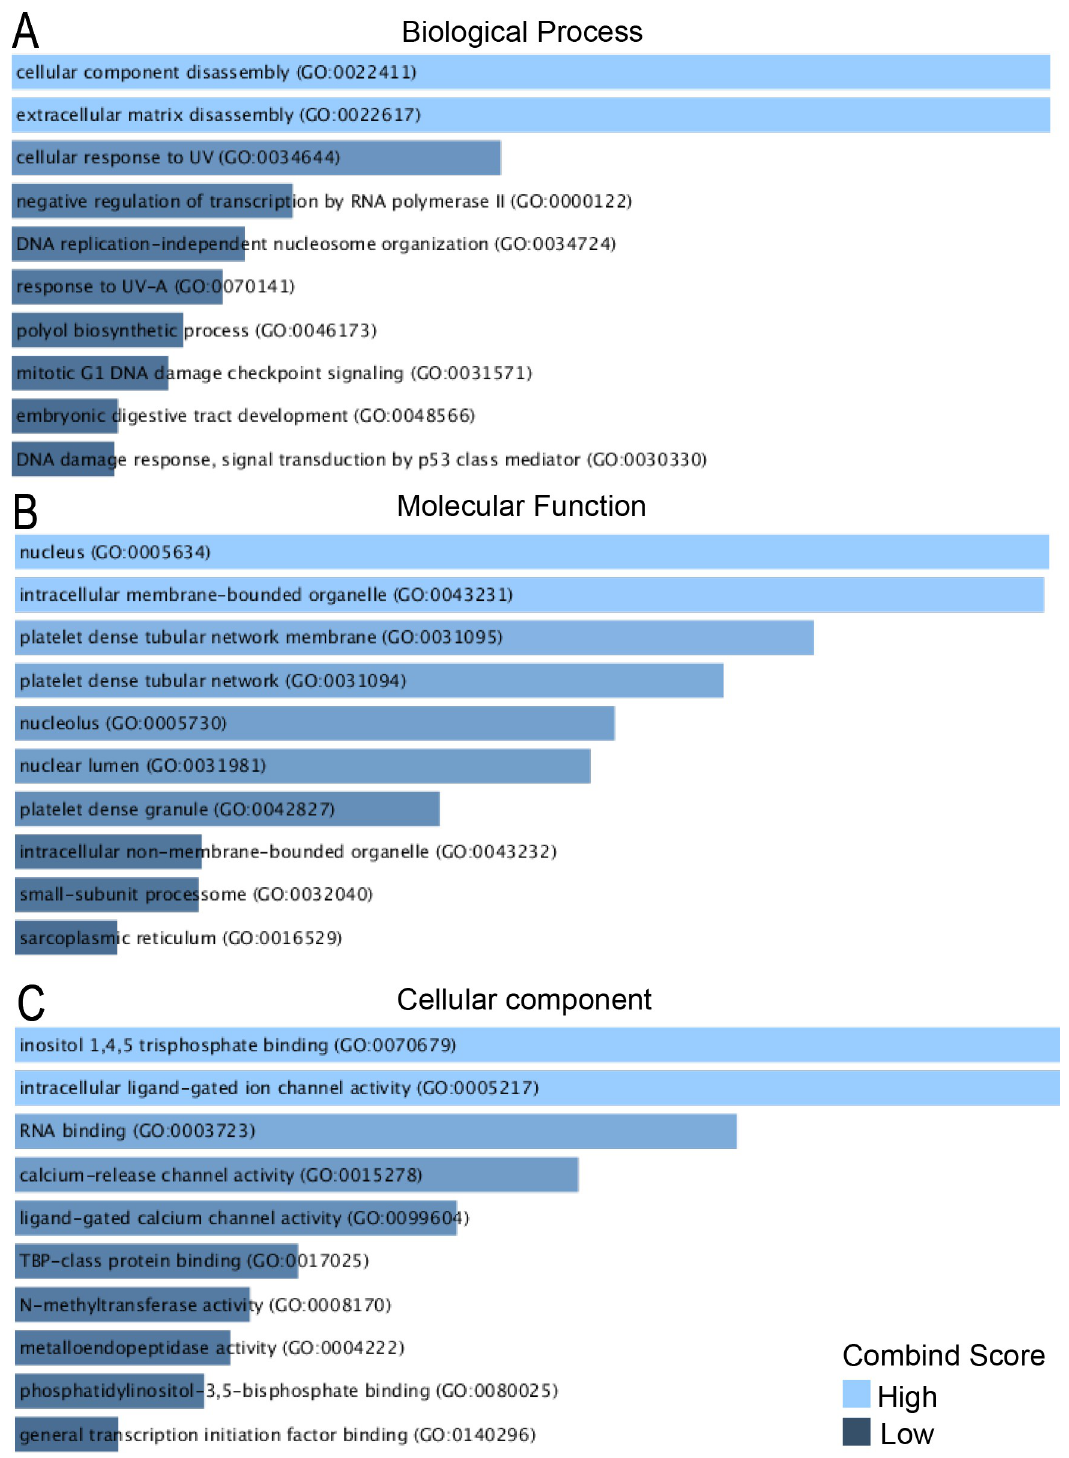
Fig 5. GO terms of downregulated DEGs between COVID-19 and IPF. A: GO analysis of downregulated DEGs according to biological process. B: GO analysis of downregulated DEGs according to molecular function. C: GO analysis of downregulated DEGs according to cellular